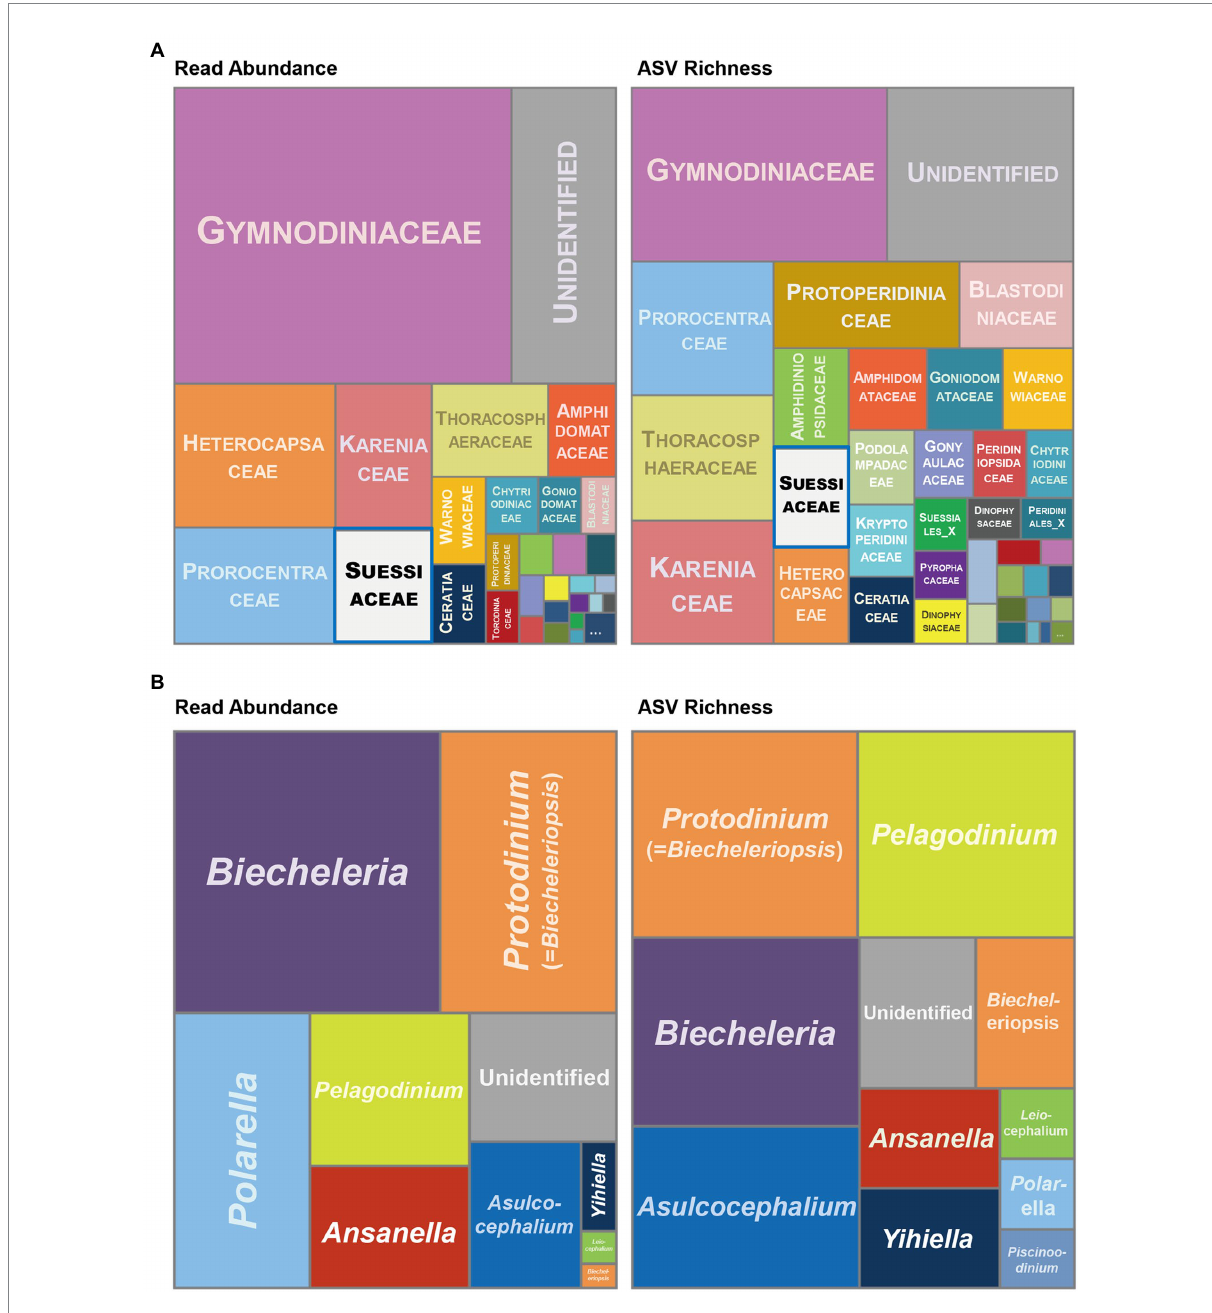
FIGURE 1 Treemaps displaying taxonomic composition and relative abundance of dinoflagellates based on 18S rRNA gene metabarcoding at (A) the family level and (B) the genus level within the family Suessiaceae. The left side represents the number of reads while the right side is the number of amplicon sequence variants (ASVs). The taxon Suessiaceae in (A) is marked with a blue box. Detailed data on the taxa and values used in this analysis are separately provided in Supplementary Table